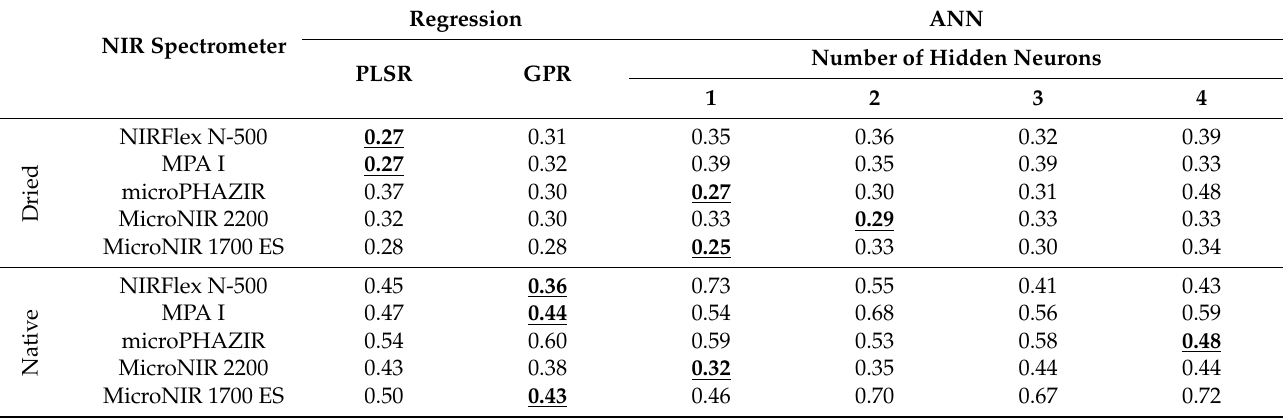
Table 10. RMSEP values for validation of an independent test set resulting from PLSR, GPR, and ANN. The best performance levels are highlighted. Reproduced (CC-BY 4.0 license) from [31].